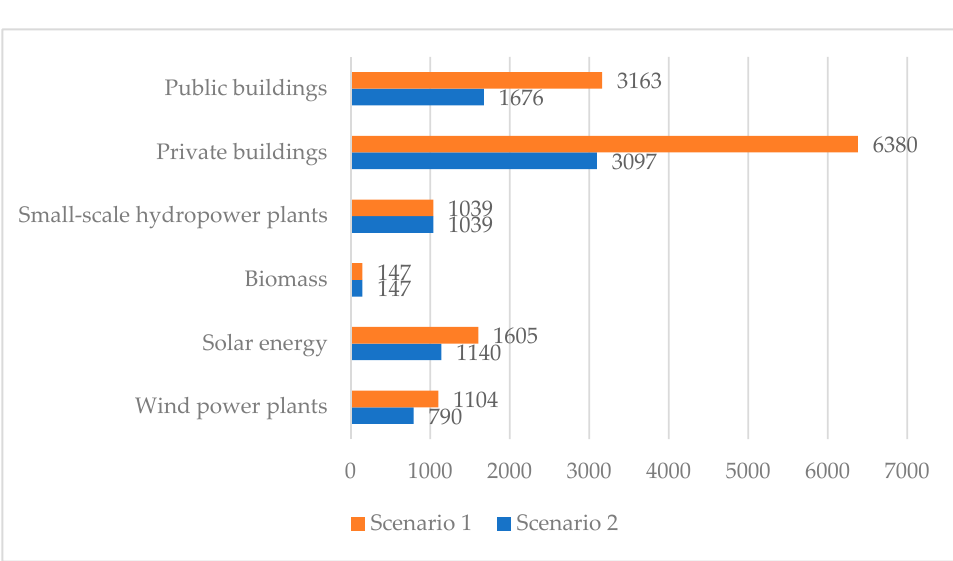
Figure 2. Total GVA effects of investments in RES and buildings retrofit in the period 2020–2050, in million EUR. Source: authors’ calculation.